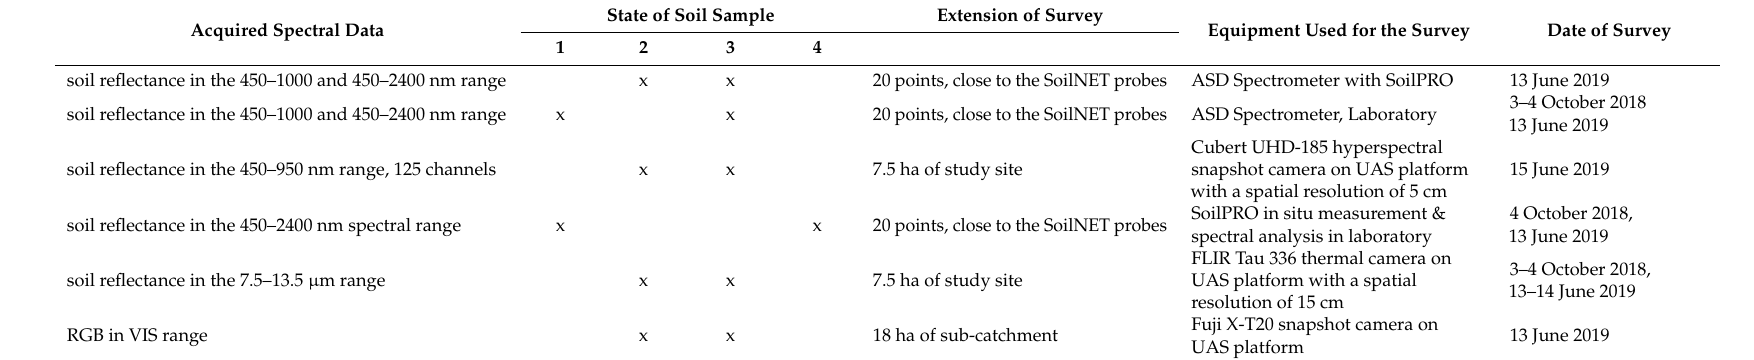
Table 2. Spectral information acquired by spectrometer and UAS platform for the MFC2-Alento Catchment. Acquired Spectral